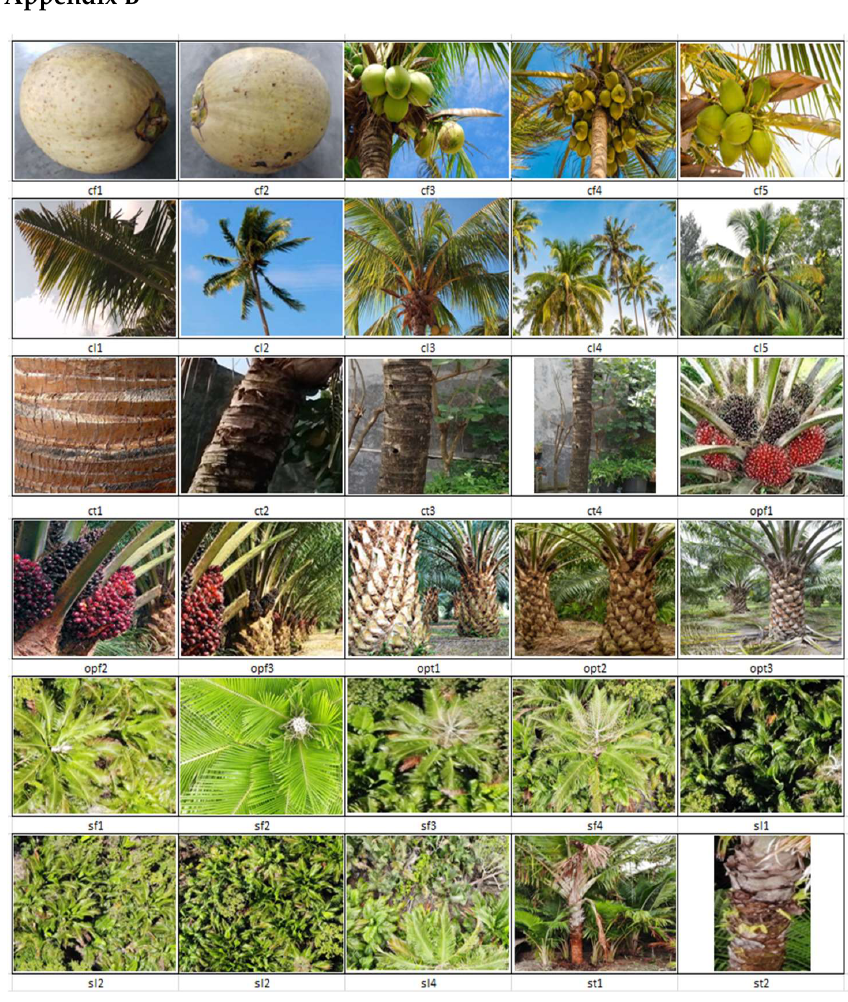
Figure A2. Sample dataset: training data.